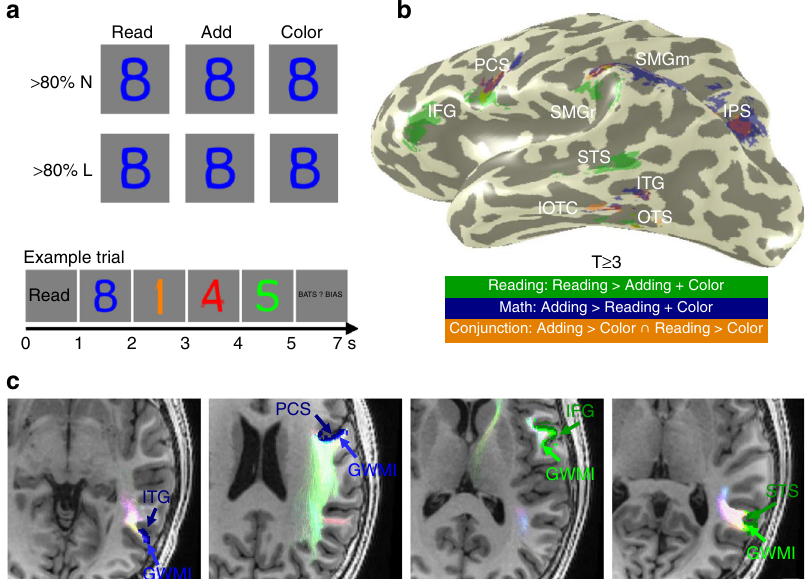
Fig. 1 Identi fi cation of gray matter regions of the math and reading networks and their functionally-de fi ned white matter tracts (fWMT). a FMRI experiment used to de fi ne math- and reading-related regions. Subjects viewed morphs between numbers and letters, containing either >80% letter (<20% number) or >80% number (<20% letter) information. At the beginning of each trial, a cue (Read/Add/Color) indicated which task should be performed, then four stimuli of the same morph type appeared for 1 s each, followed by an answer screen presented for 2 s. Subjects indicated their answer with a button press. Identical stimuli were presented across tasks. Trial structure is shown at the bottom. b Gray matter functional regions of interest (fROIs) of the math and reading networks. Green: Reading-related regions were de fi ned based on higher responses in the reading task than other tasks; Blue: Math-related regions were de fi ned based on higher responses in the adding task than other tasks; Orange: Regions that responded more strongly during reading vs. color and adding vs. color tasks. All fROIs were de fi ned using a T ≥ 3 (voxel level) threshold in each participant ’ s brain. c Example fROIs and their respective fWMTs in axial slices of a representative participant. Blue: Math fROIs. Green: Reading fROIs; lighter shades of blue and green under each fROI: respective gray- white-matter-interface (GWMI) of that fROI. The fi ber tracts that terminate at the GWMI of each fROI are shown in pastel colors; the colors of the tracts indicate the main diffusion direction, pink: right/left; light green: anterior/posterior; light blue: superior/inferior. Scale bar in c indicates 1 cm. IFG inferior frontal gyrus, PCS precentral sulcus, SMGr reading fROI in supramarginal gyrus, SMGm math fROI in supramarginal gyrus, STS superior temporal sulcus, ITG inferior temporal gyrus, OTS occipito-temporal sulcus, IPS intraparietal sulcus, lOTC lateral occipito-temporal